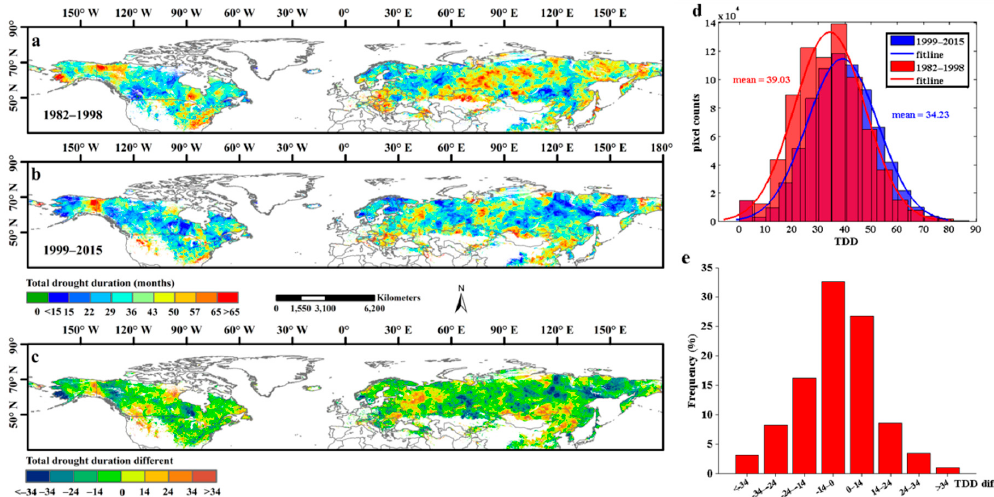
Figure 6. The spatial distribution of total drought duration (TDD) of each pixel in Northern